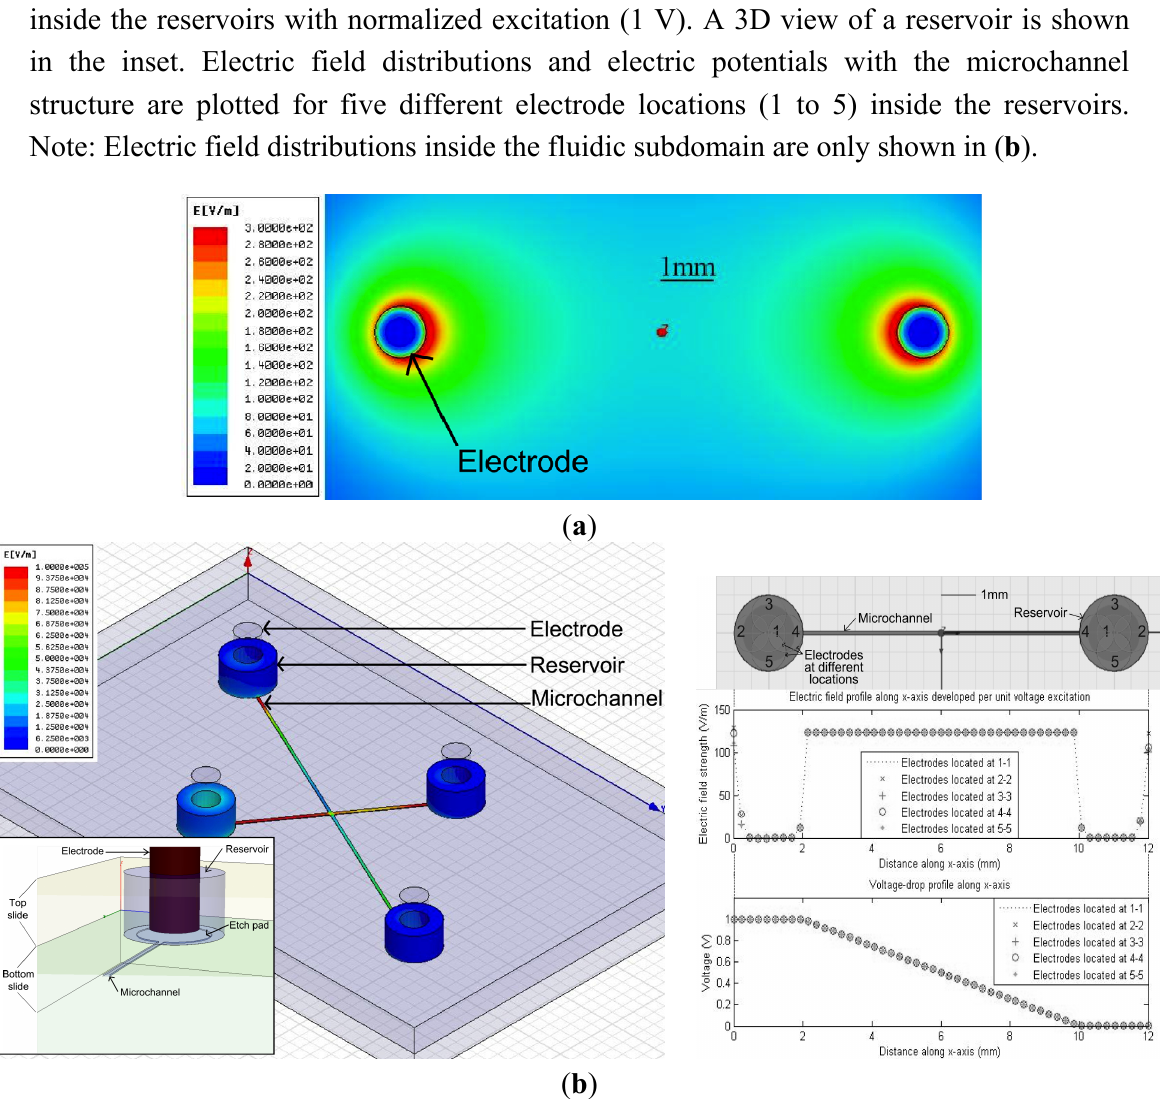
Figure 1. Finite element method (FEM) simulations ( a ) without and ( b ) with microchannel structures (microchannels of 100 μ m-wide and 20 μ m-deep) that depict high electric